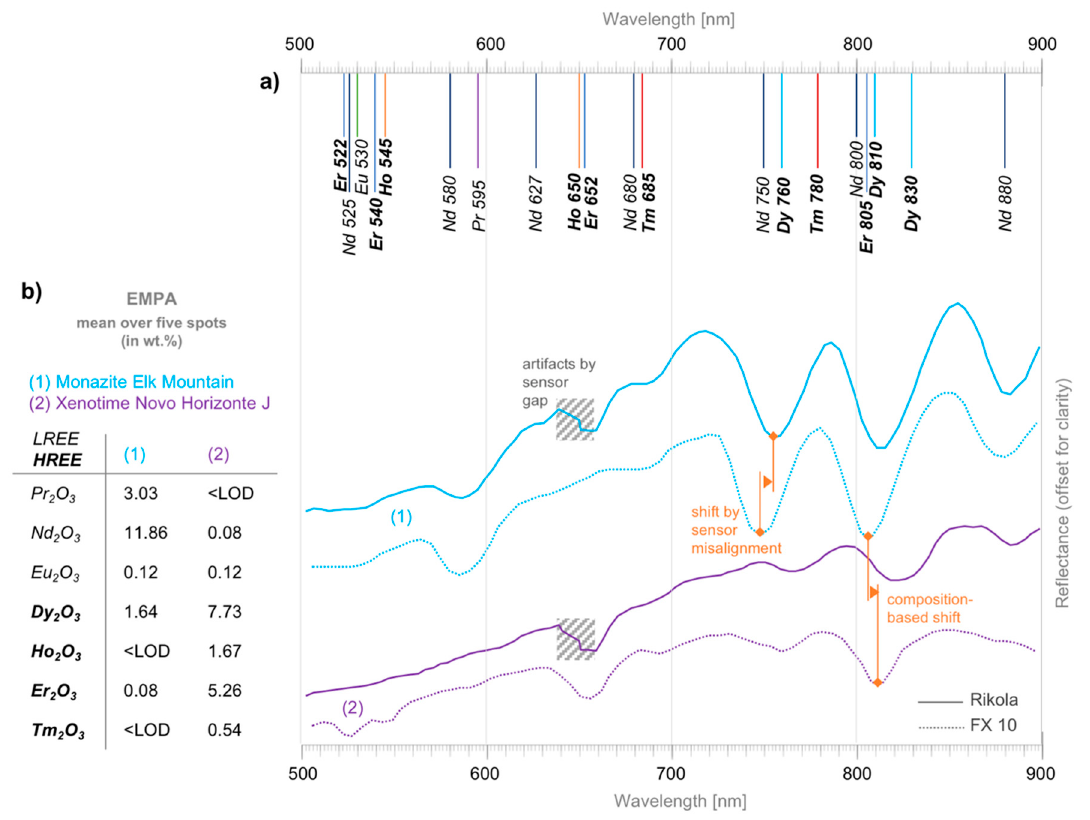
Figure 3. ( a ) Position of the most characteristic REE absorption features in the VNIR range according to the analysis of single-REE salts and literature review, ( b ) extracted spectra from HS imaging of natural mixed REE mineral samples using two different HS sensors. Sample (1) represents LREE-enriched grains, while (2) is HREE-dominated. EMPA analysis results are given as mean of a series of five measurements (<LOD: below Limit of Detection).